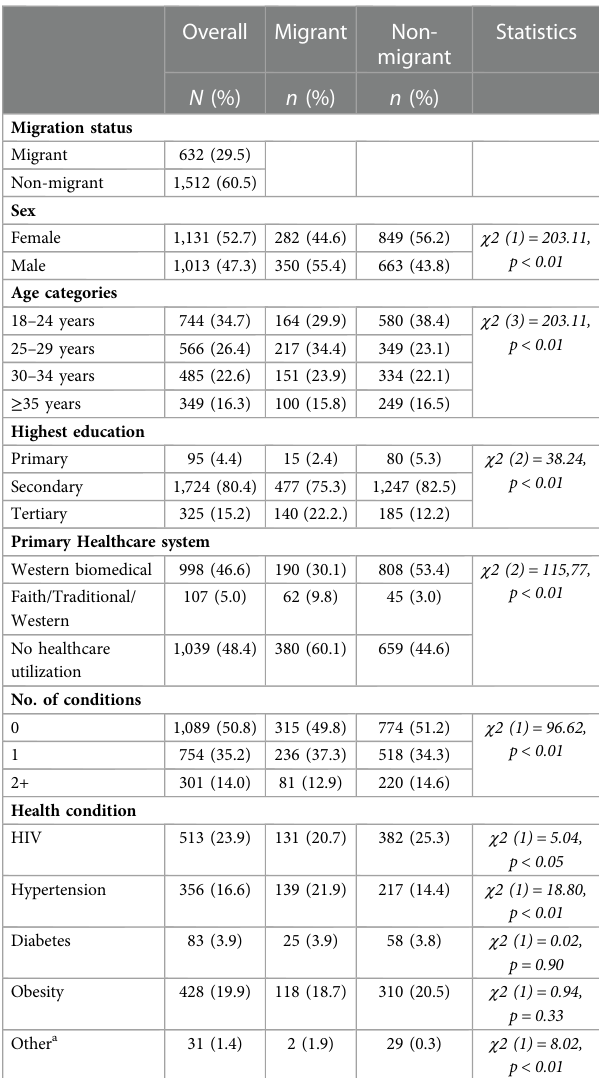
TABLE 1 Description of the sociodemographic and health characteristics of adults in the multimorbidity sample from the migrant health follow-up study (MHFUS) ( N